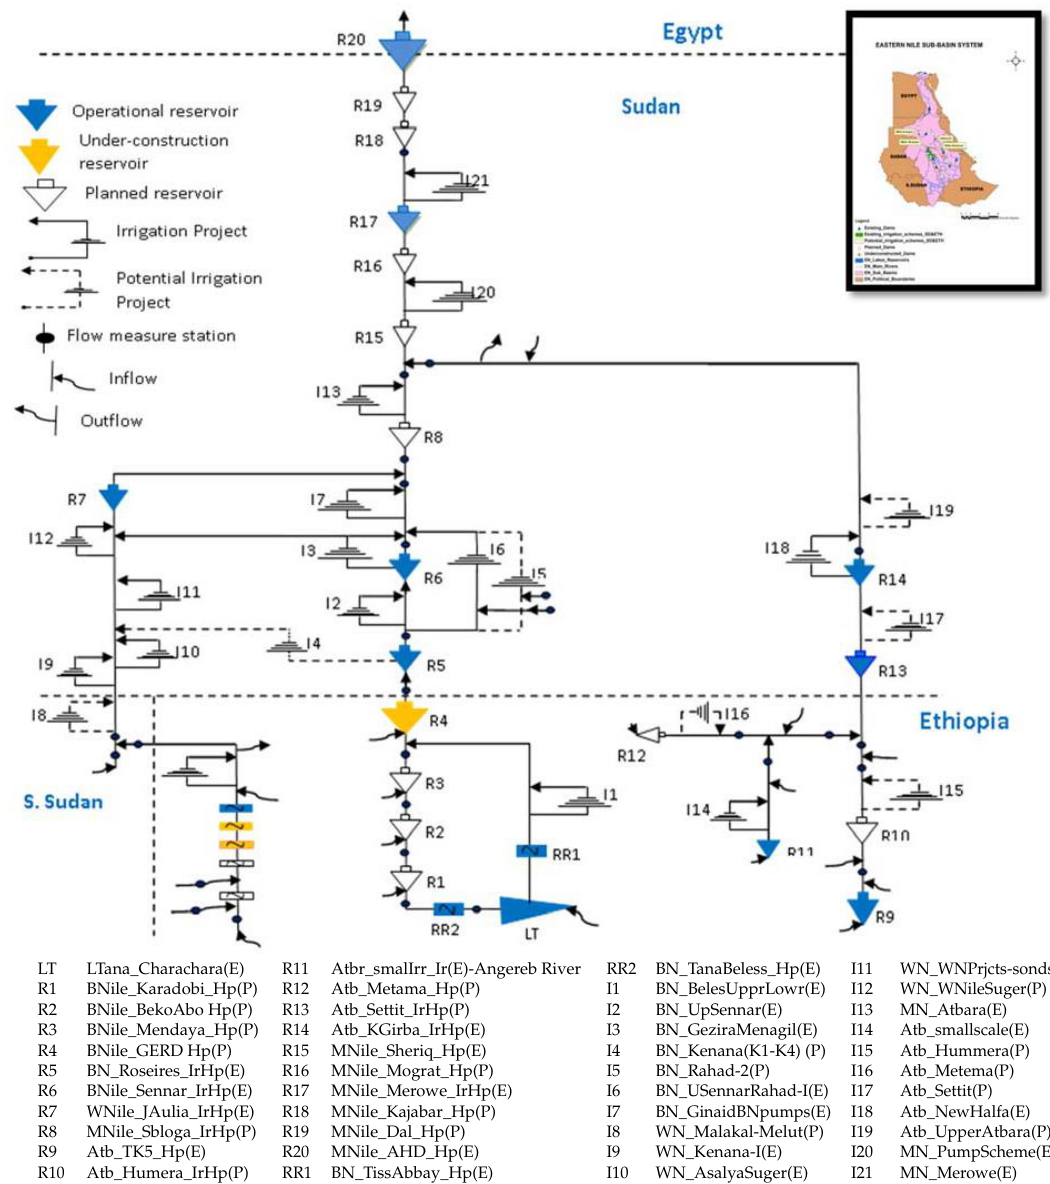
Figure 3. The Eastern Nile River